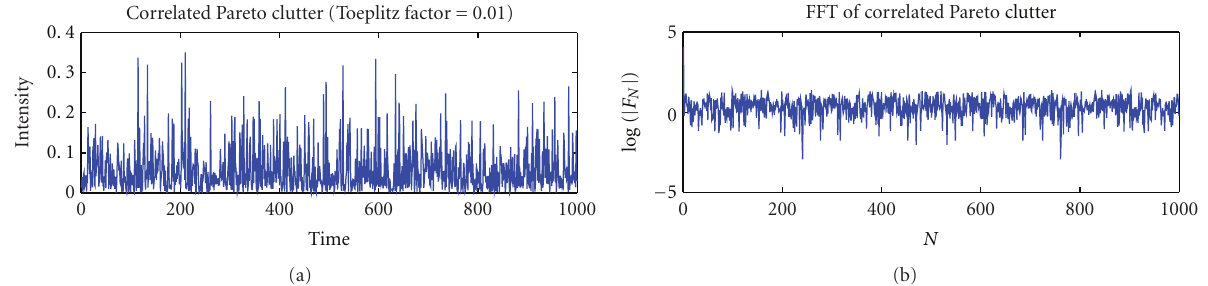
Figure 1: An example of correlated Pareto clutter returns, where the correlation is small. (a) shows the clutter in the time domain, while the (b) is the result of a fast Fourier transform (FFT) applied to the same clutter.